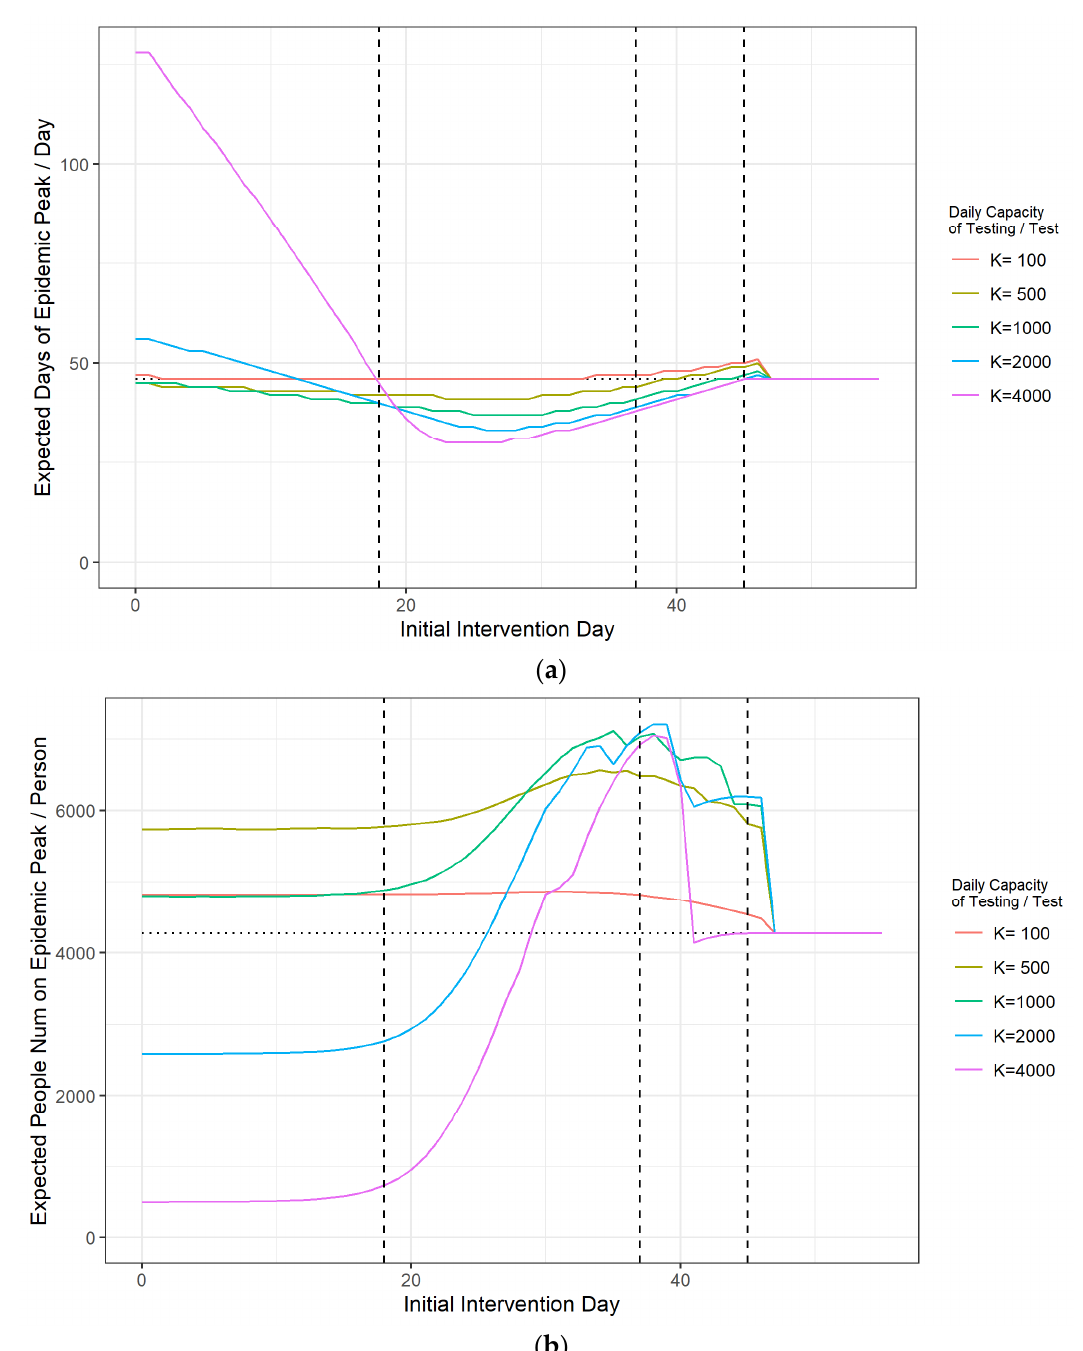
Figure 3. Effect of daily testing capacity and initial intervention timing of the peak of the epidemic. ( a ) Time when the peak of the outbreak arrived; ( b ) Number of the infected at the peak of the epidemic.